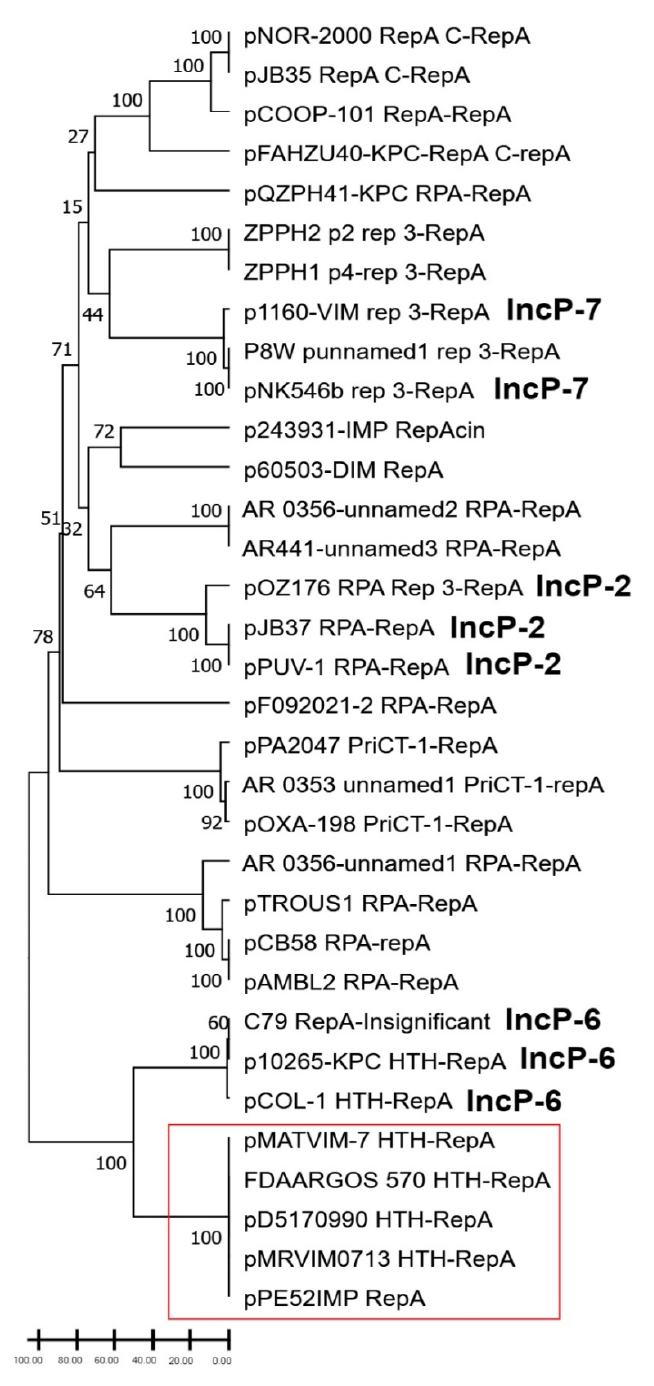
Figure 2. UPGMA phylogenetic tree of replicase A proteins in plasmids carrying resistance genes. The incompatibility groups of the plasmids are in bold type. Replicases in the same clade as pPE52IMP RepA are enclosed in a red box.